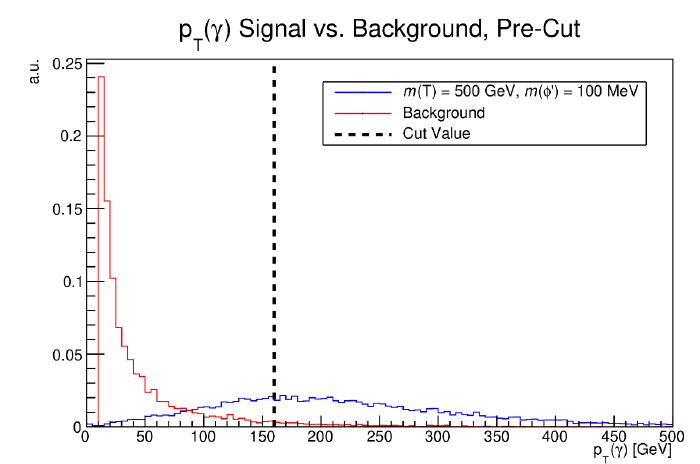
Figure 6 . p T ( γ ) distribution for signal (blue) and background (red) samples. Signal events were generated assuming m ( T ) = 500 GeV , m ( φ 0 ) = 100 MeV . The y -axis normalization is arbitrary. The vertical black dashed line denotes the location of the selection cut.